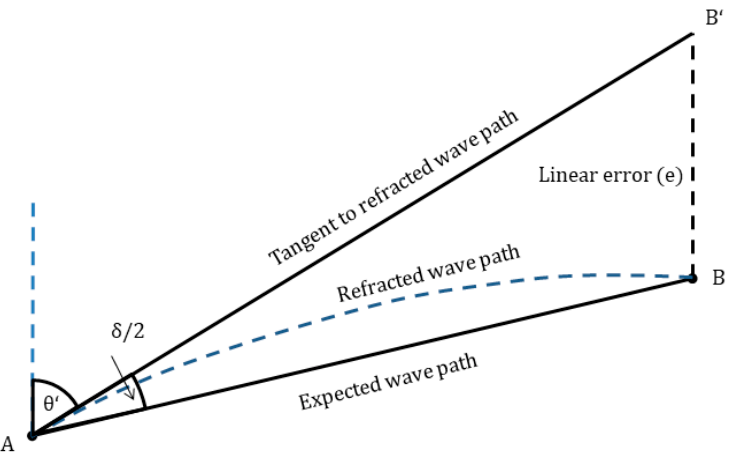
Figure 2. The effects of atmospheric refraction (after [ Error! Reference source not found. ]). Figure 2. The e ff ects of atmospheric refraction (after